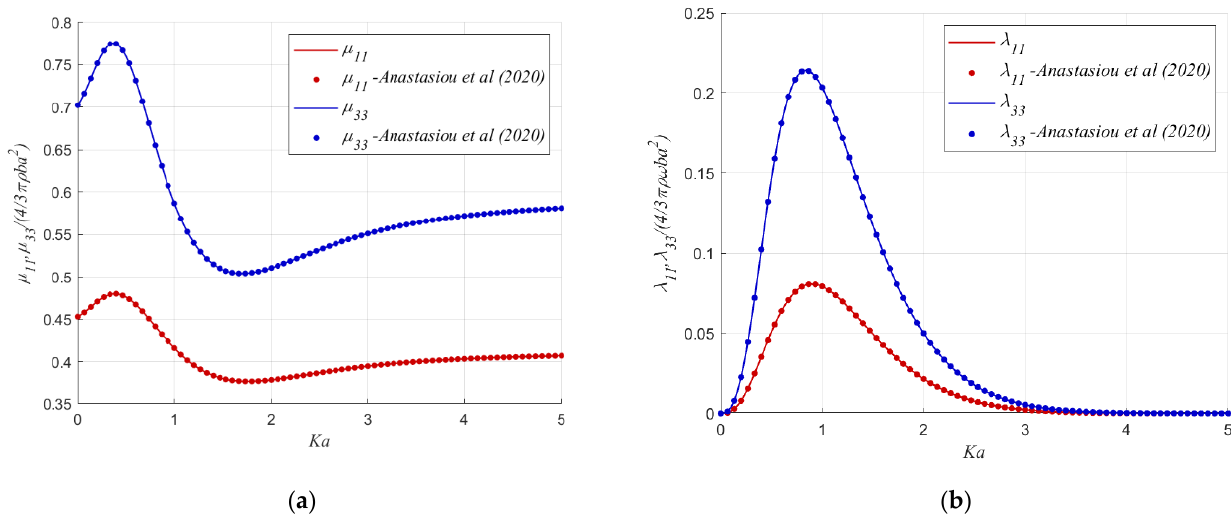
Figure 5. Normalized hydrodynamic coefficients in heave and surge for a / b = 1.25, f = 1.5 a and infinite water depth: ( a ) added mass; ( b ) hydrodynamic damping.